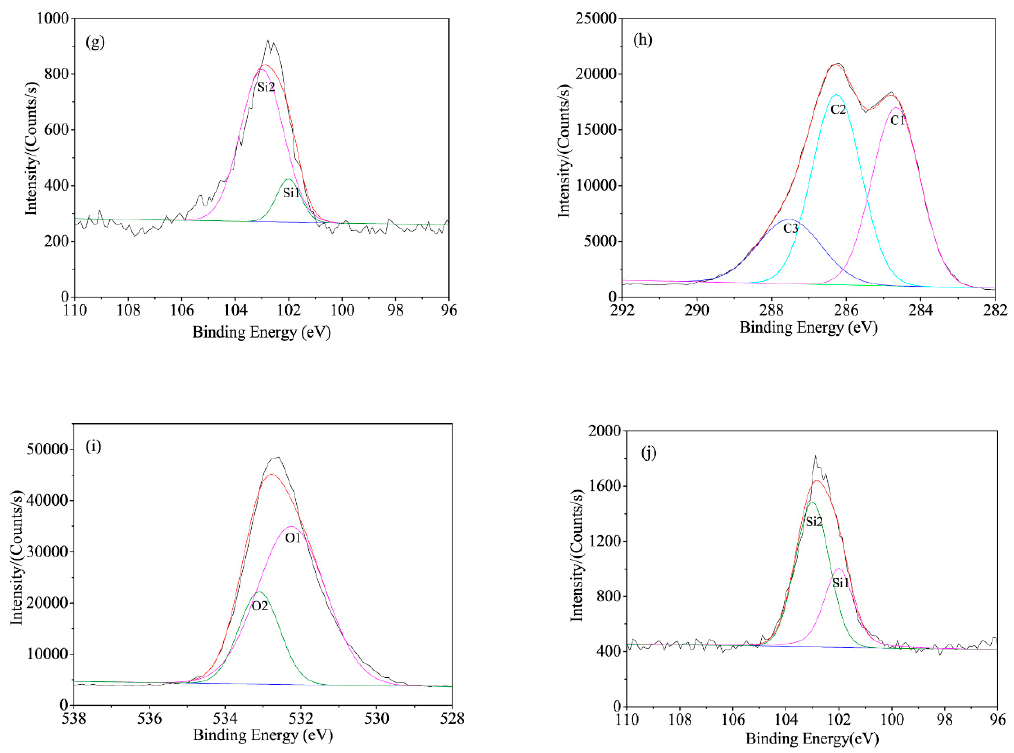
Figure 4. Peak differentiating curves of BF: ( a ) UBF-C1s; ( b ) UBF-O1s; ( c ) ABF-C1s; ( d ) ABF-O1s; ( e ) SBF-C1s; ( f ) SBF-O1s; ( g ) SBF-Si2p; ( h ) ASBF-C1s; ( i ) ASBF-O1s; ( j ) ASBF-Si2p. Table 3. XPS data of BF modified by various methods